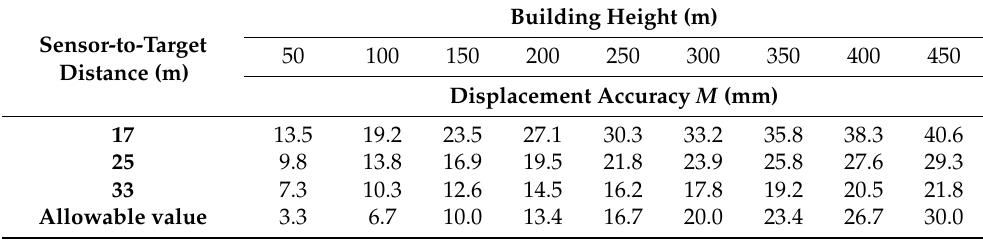
Table 8. Accuracy dependency between the chain’s length and building height.